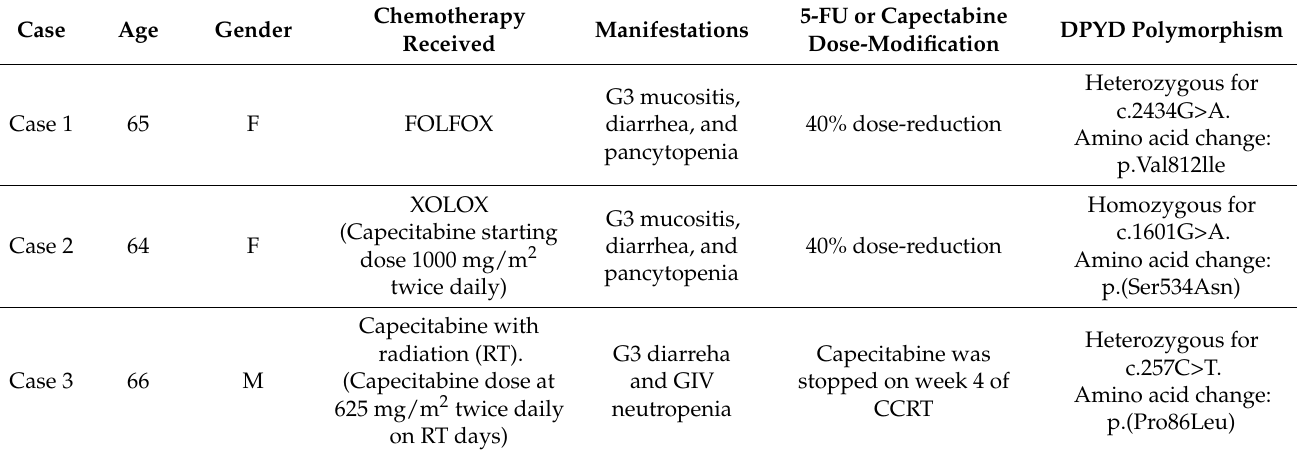
Table 1. Patients clinical characteristics, polymorphisms identified and treatments